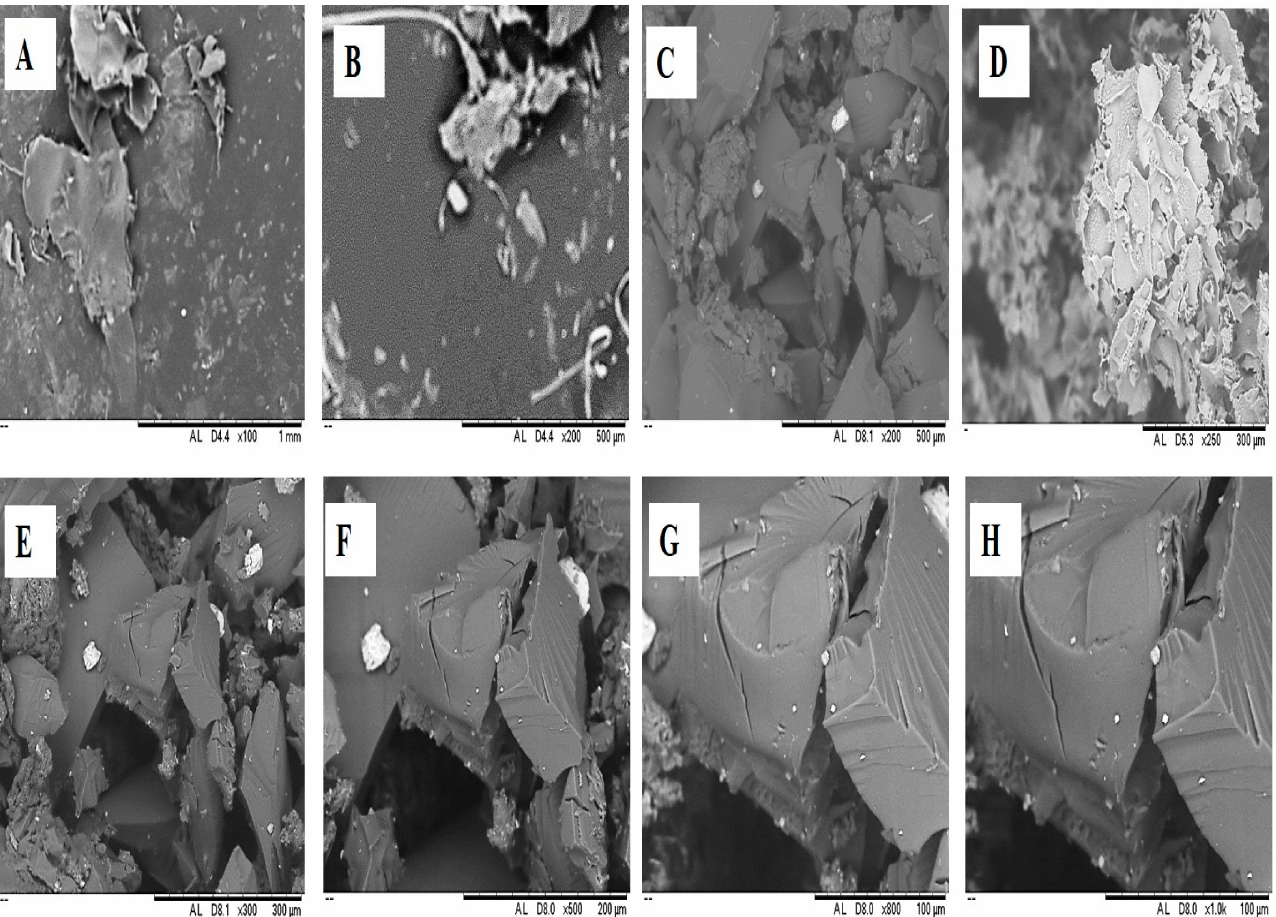
Figure 5. SEM analysis of chemically grafted thermoresponsive Poly (NVCL-g-NaAlg) in situ depot hydrogels. Surface morphology × 100 ( A ), × 200 ( B ), Cross-sectional morphology × 200 ( C ), × 250 ( D ), × 300 ( E ), × 500 ( F ), × 800 ( G ), and × 1000 ( H